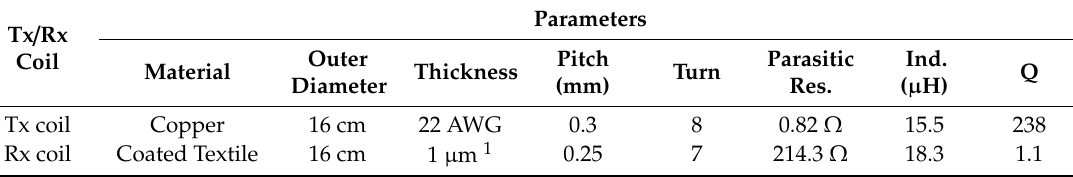
Figure 5. ( a ) Measured Q factor of wire-wound Tx coil for 200 kHz, 2 MHz, and 6.78 MHz carrier frequencies without power-amplifier (PA) output resistance; ( b ) 𝑄 𝑅′ optimization for designated Q T R considering n PDL and n PTE ; and ( c ) resulting Q factor of conductive-thread textile Rx coil vs. number of turns at 2 MHz carrier frequency. Table 1. Parameters of transmitter (Tx) and receiver (Rx)